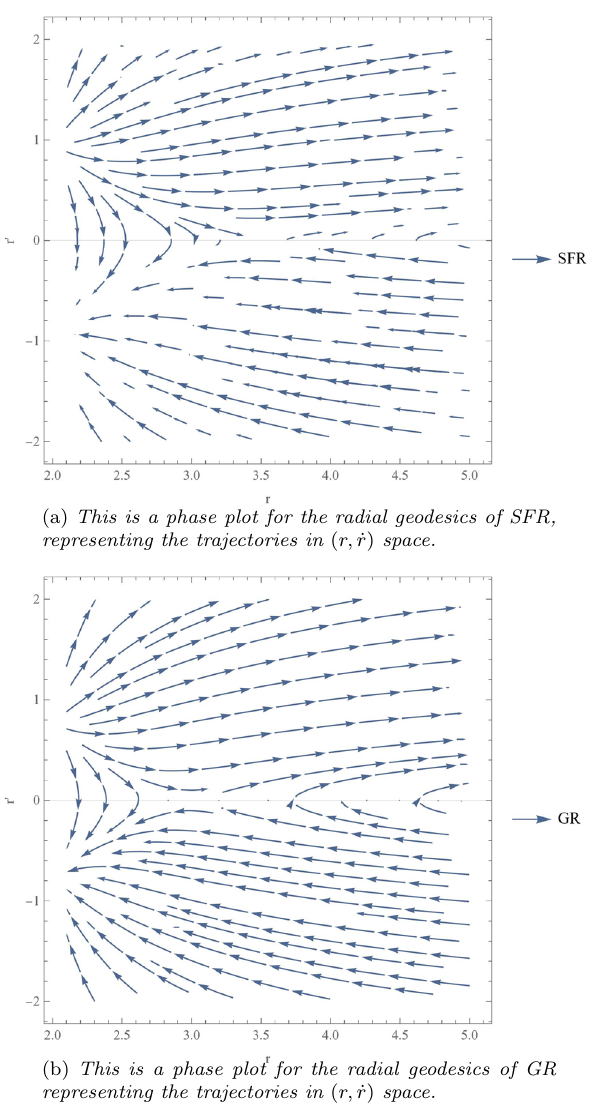
(b) This is a phase plot for the radial geodesics of GR representing the trajectories in ( r, ˙ r ) space. Fig. 4 These are phase plots for the radial geodesics of the GR and SFR models